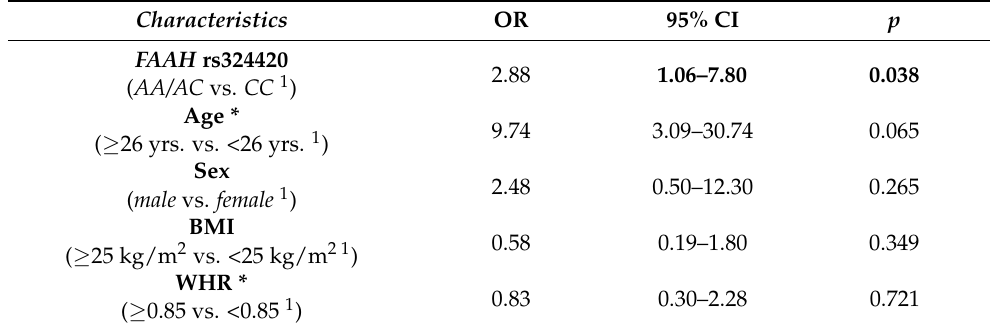
Table 4. Multivariate analysis using binomial regression on the athletic performance considering FAAH rs324420 and relevant